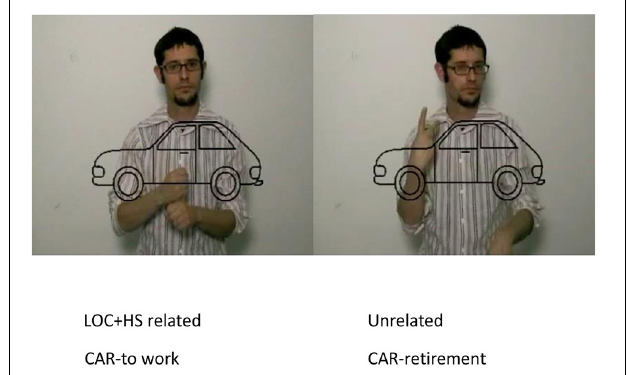
FIGURE 1 | An example of the stimuli employed in the experiment. The sign corresponding to the picture CAR is formed by the A- Handshape, located in the neutral space and with a movement that resembles the action of moving the steering wheel. This sign shares the Location (LOC) and the Handshape (HS) with the sign TO WORK (left image) and does not share any of these parameters with the sign RETIREMENT (right image).